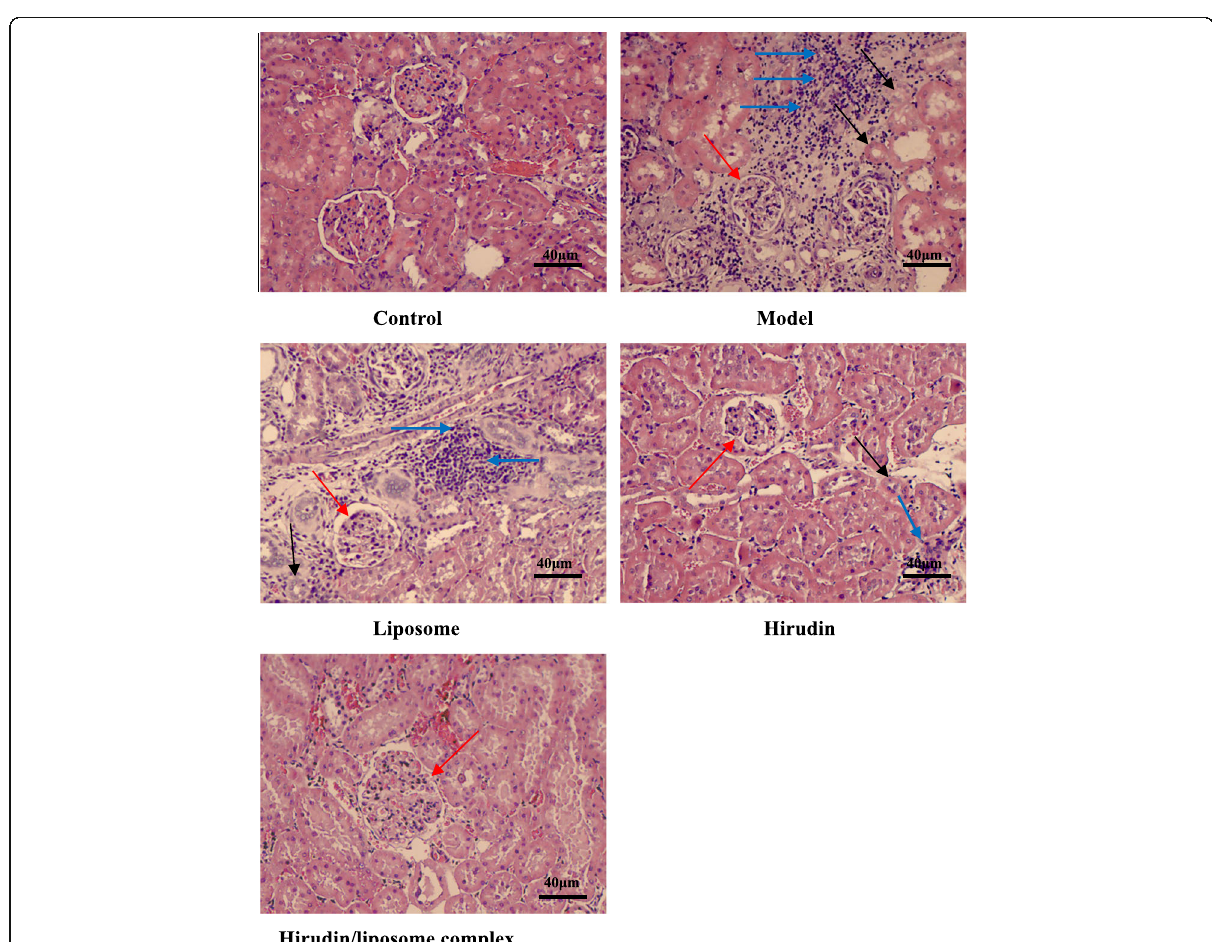
Fig. 7 HE staining indicated that pathological changes including the hyperplasia of the glomerular mesangial matrix, tubular atrophying and infiltration of inflammatory cells could be noted in Model group. The hirudin/liposome complex treatment reduced the atrophying of kidney tubules and infiltration of inflammatory cells in the DN rat model. (Red arrows indicate hyperplasia of the glomerular mesangial matrix; black arrows indicate atrophying of kidney tubules; blue arrows indicate infiltration of inflammatory cells, 20x). Control group ( n = 10), Model group ( n = 7), Liposome group ( n = 7), Hirudin group ( n = 8), Hirudin/liposome complex group ( n =